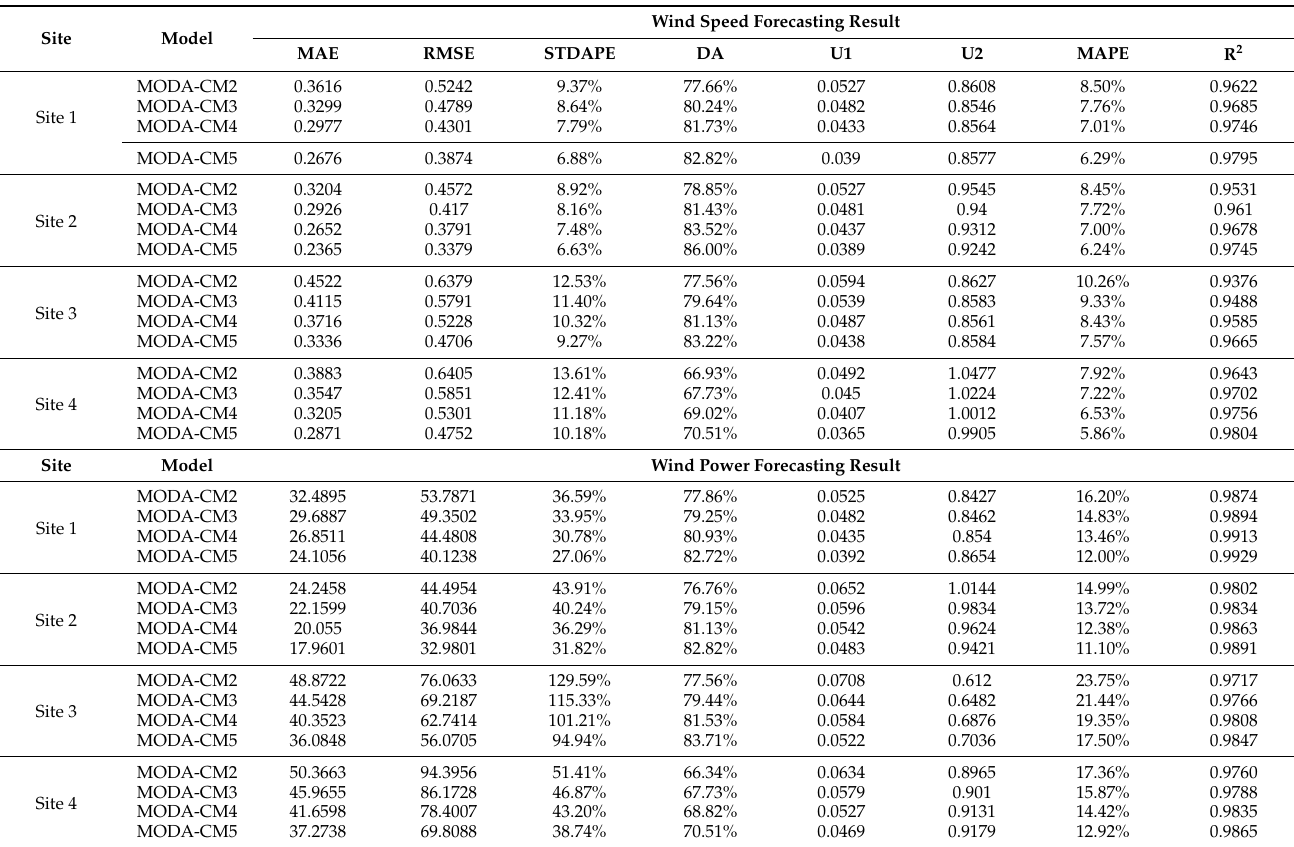
Table 6. The forecasting result of wind speed and wind power in the third